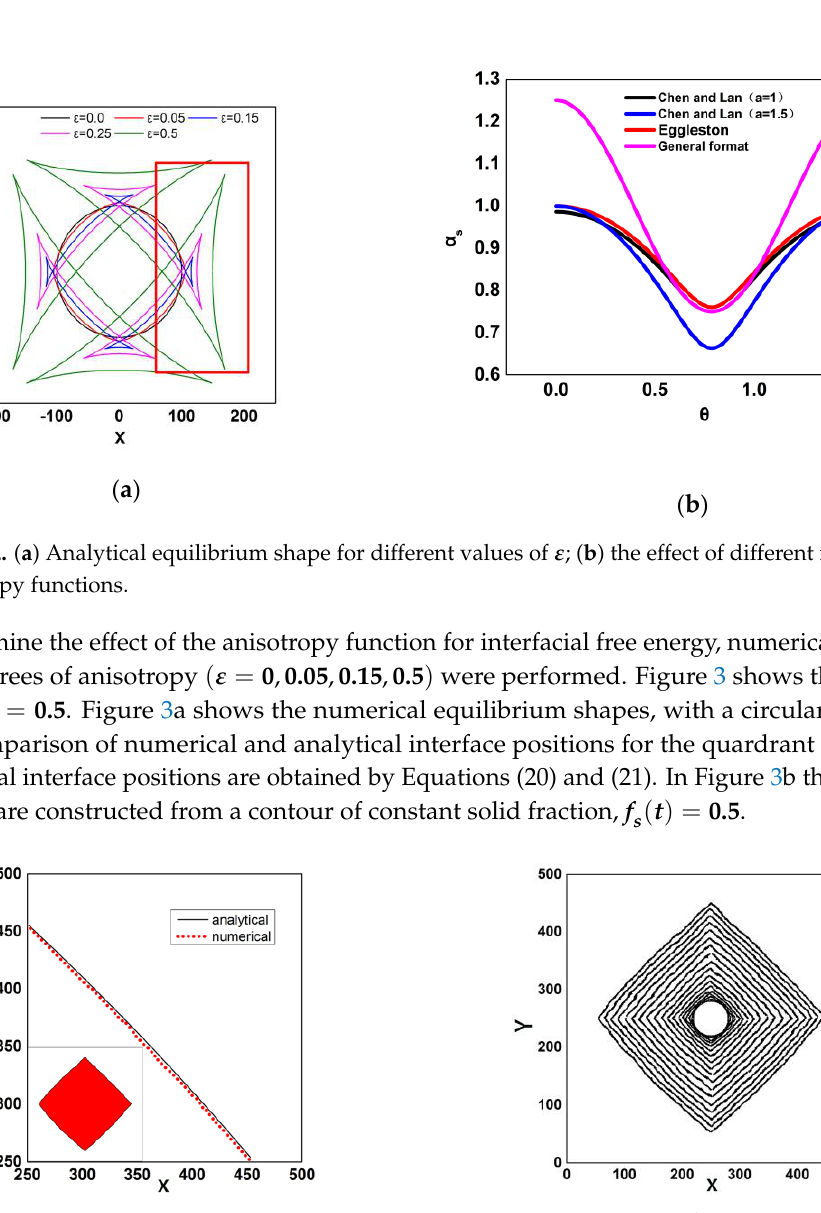
( b ) Figure 4. Simulation results of temperature: ( a ) entire simulation area; ( b ) normal direction of 0° and 45°. Similarly Figure 5 shows the numerical results for 1500500 .,., 